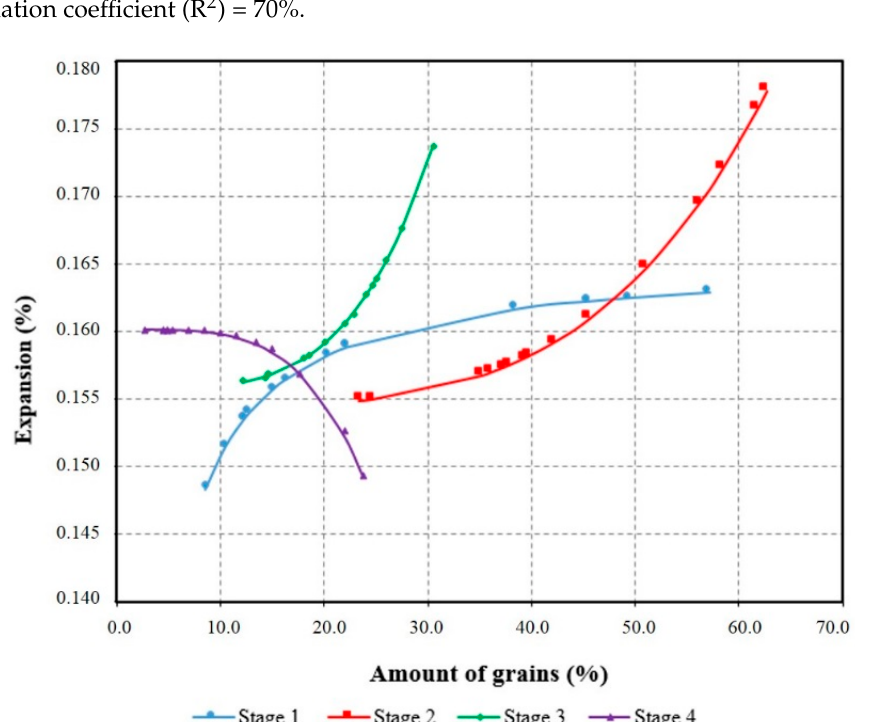
Figure 12. Representative curves of the model obtained model to evaluate the influence of the stages of deformation of the quartz in the expansions of the ASR.